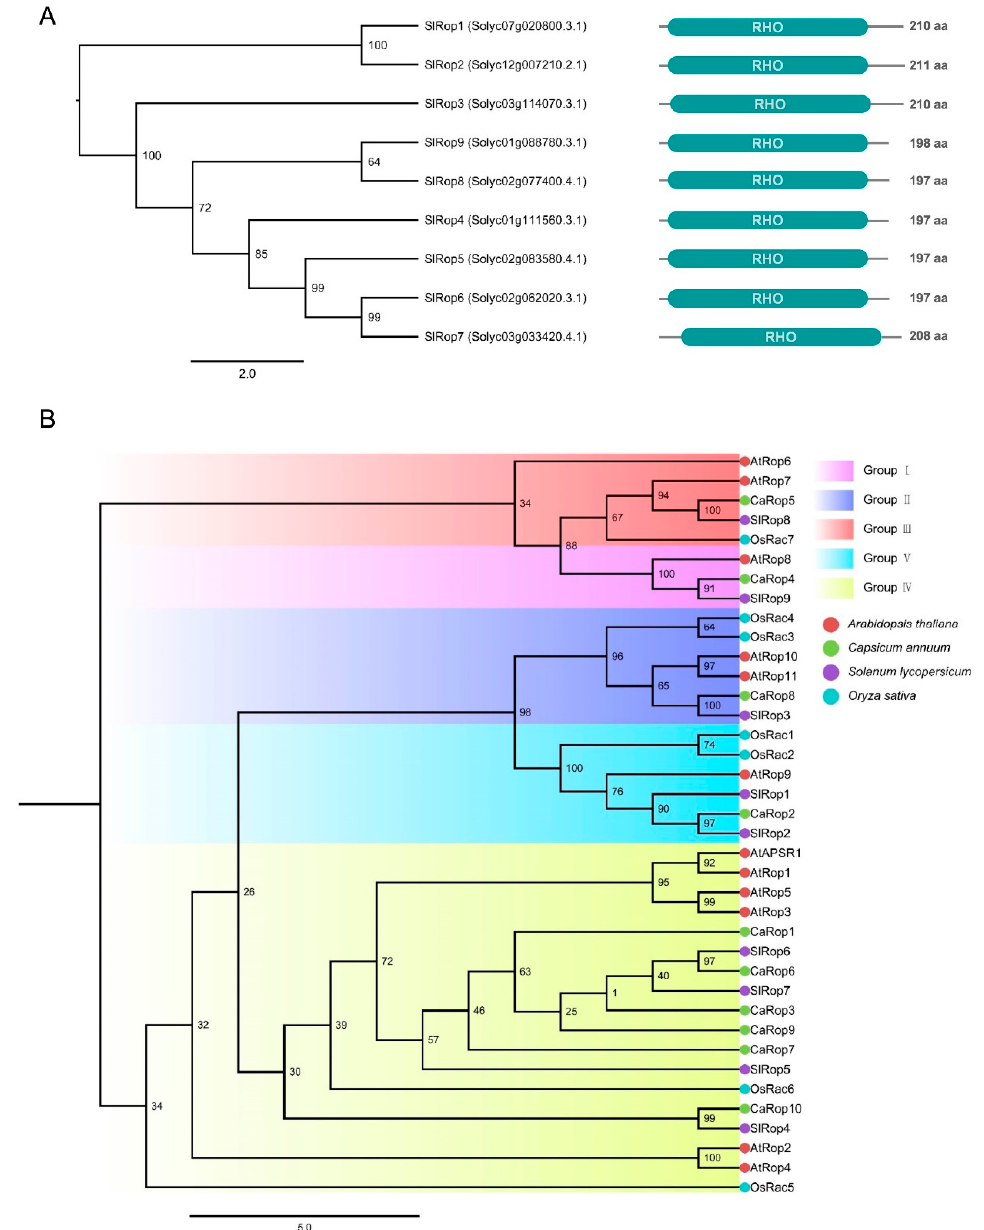
Figure 1. Phylogeny of SlRops identified in Solanum lycopersicum ( A ), Phylogenetic and characteristic analysis of nine Rops from the tomato genome database. Left panel, the phylogenetic tree constructed using the protein sequences of nine genes with IQ-TREE. A multiple protein sequence alignment was generated using the MUSCLE tool (Edgar 2004), followed by trimming using TrimAI. The numbers at each node indicate the bootstrap support value calculated from one thousand replicate settings. Right panel, the corresponding schematic diagram of the protein domain structure predicted by SMART. The protein length of each ROP is shown on the right. aa, abbreviation for amino acid. Cyan boxes indicate the length and location of the canonical RHO domain within the Rac/Rop family small GTPases. ( B ), The evolutionary relationship among Rho-like proteins from Solanum lycopersicum , Arabidopsis thaliana , Capsicum annuum , and Oryza sativa . The phylogenetic tree was obtained similarly to that described in A. Five groups are separately presented with magenta (Group I), blue (Group II), red (Group III), yellow (Group IV), and cyan (Group V).